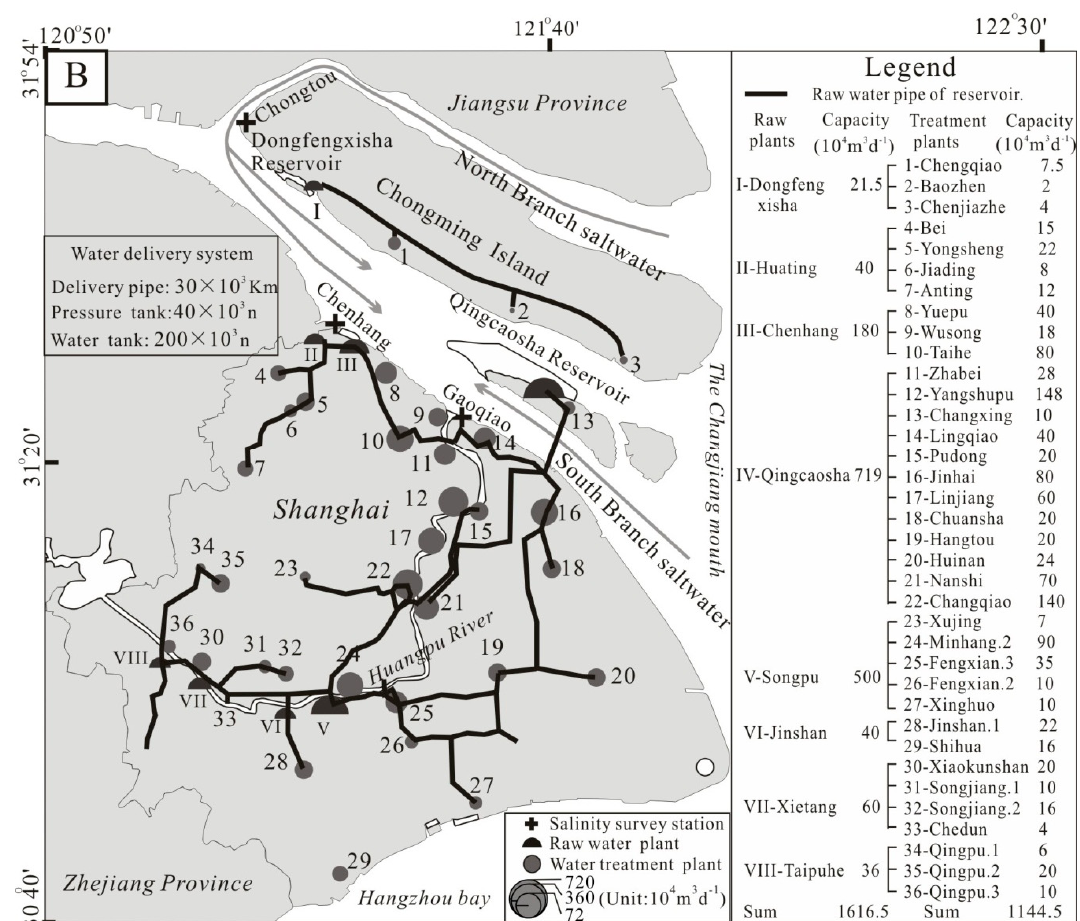
Figure 1. (A ) Flow chart of the water supply system in Shanghai, ( B ) the distribution of raw water plants, water treatment plants and water delivery pipes in Shanghai in 2013, and the sites where water quality and threat factor data were